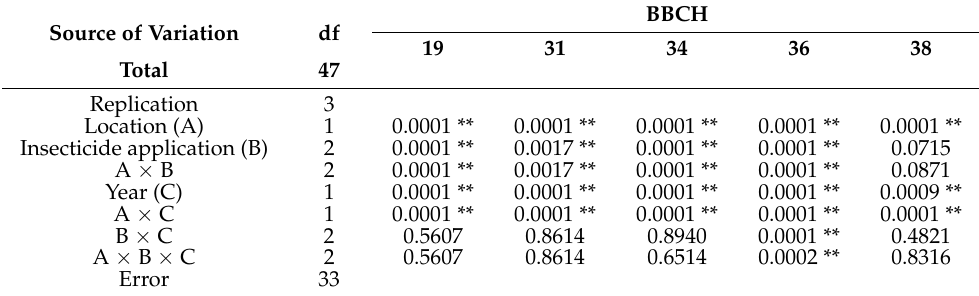
Table 8. Factorial analysis (ANOVA) of the percent of plants with damages caused by caterpillars in different developmental stages of sugar beet plants (** significant at p = 0.01.).